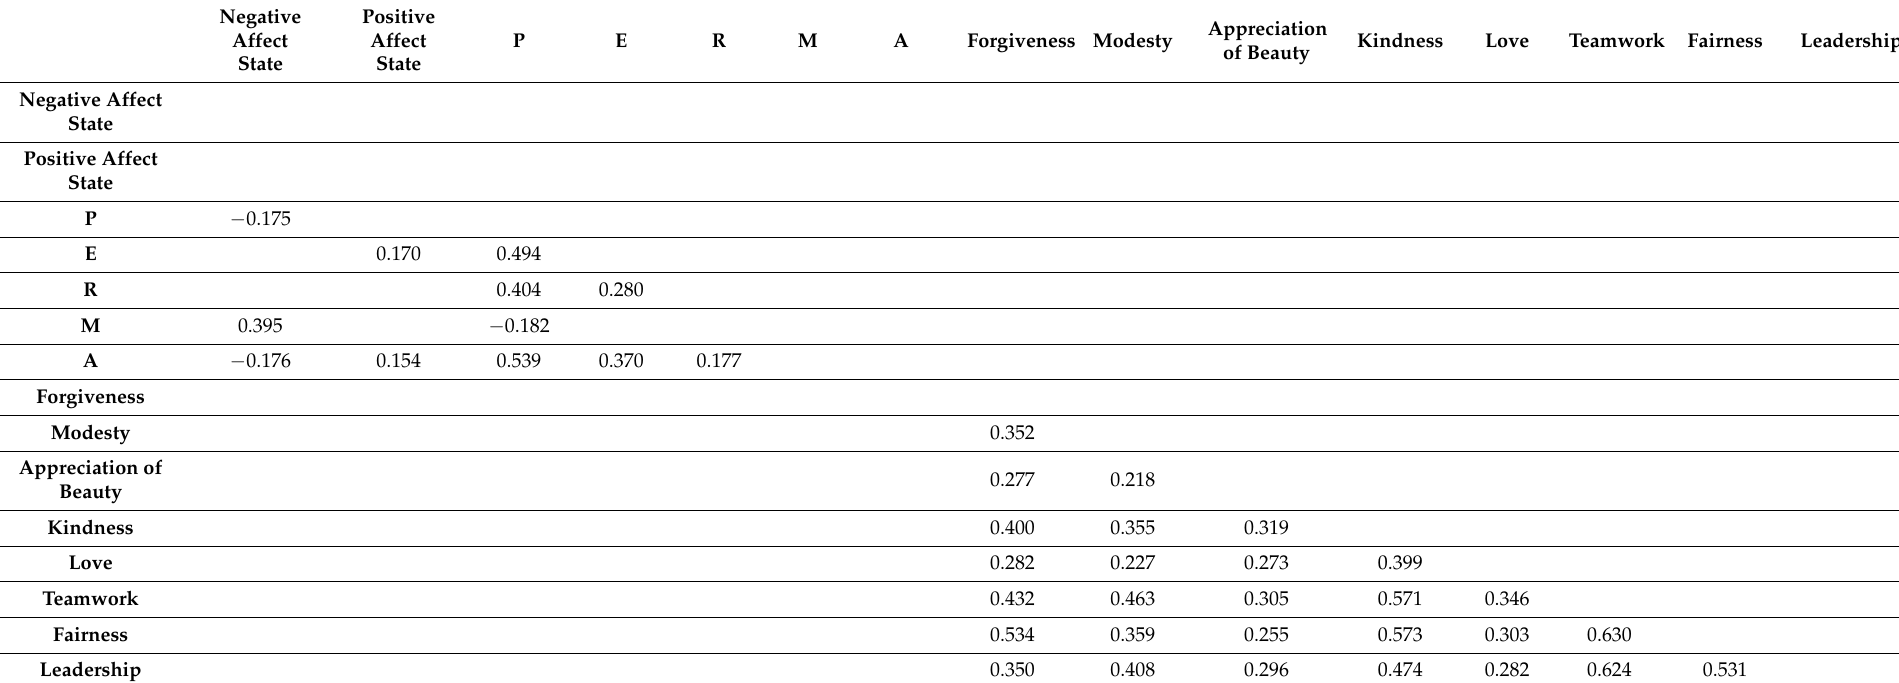
Table 2. Correlations between interpersonal virtue dimensions and subjective wellbeing